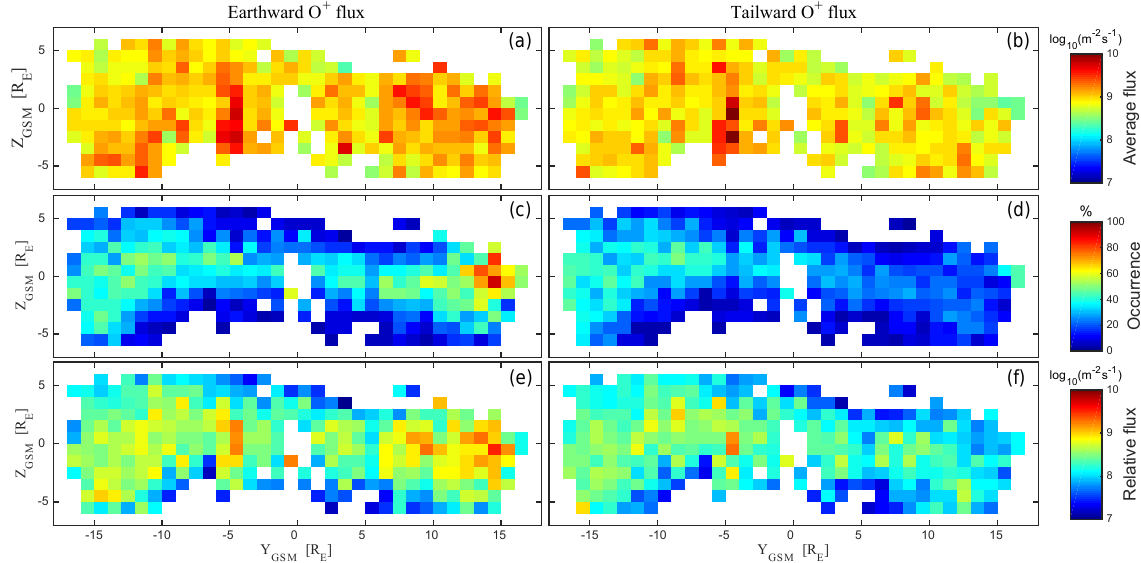
Figure 3. The spatial distributions of central plasma sheet O + fluxes. It is the same format as in Fig. 2, but note the different colour scale.